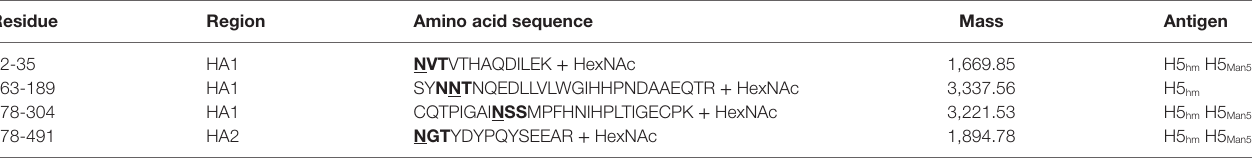
N-linked glycosylation sites are bold and underlined. Molecular mass of modified peptides (one HexNAc attached to the asparagine residue) was determined by spectrometer. HexNAc (N-acetylhexoseamine).